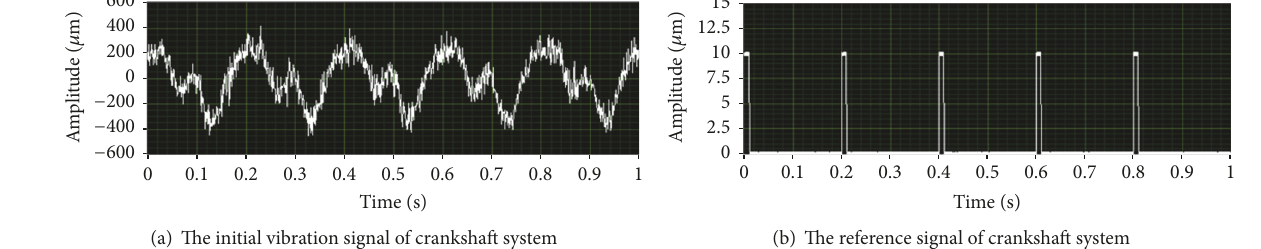
Figure 7: The initial vibration signal and reference signal of crankshaft system.